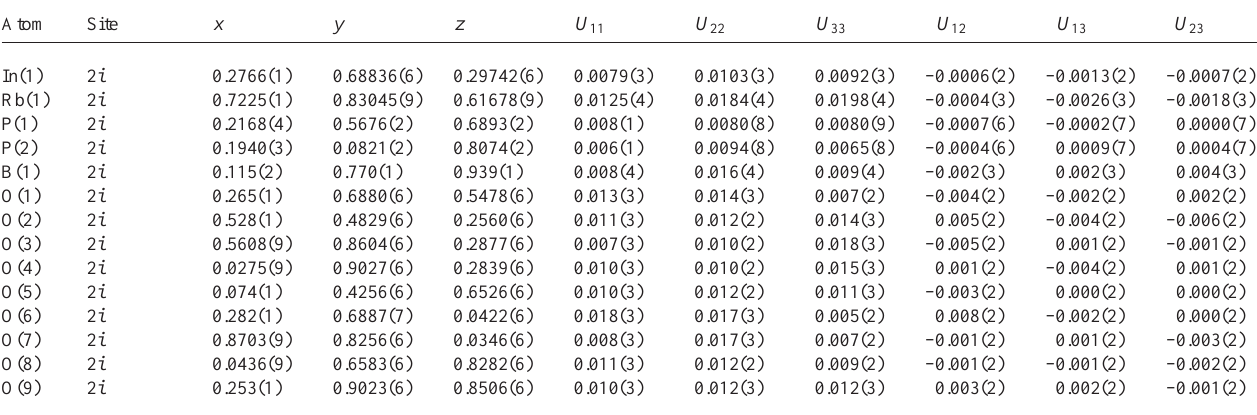
Table 3. Atomic coordinates and displacement parameters (in Å 2 )